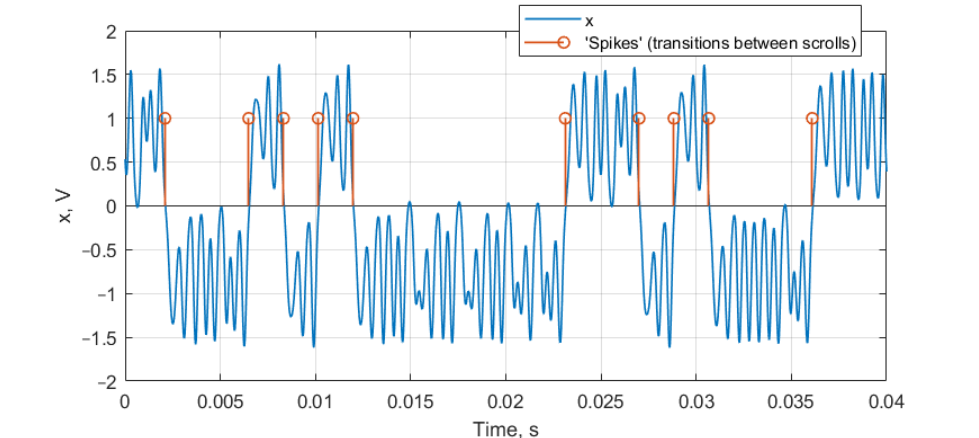
Figure 8. Conversion of two-scroll attractor chaotic system waveform x into a spike